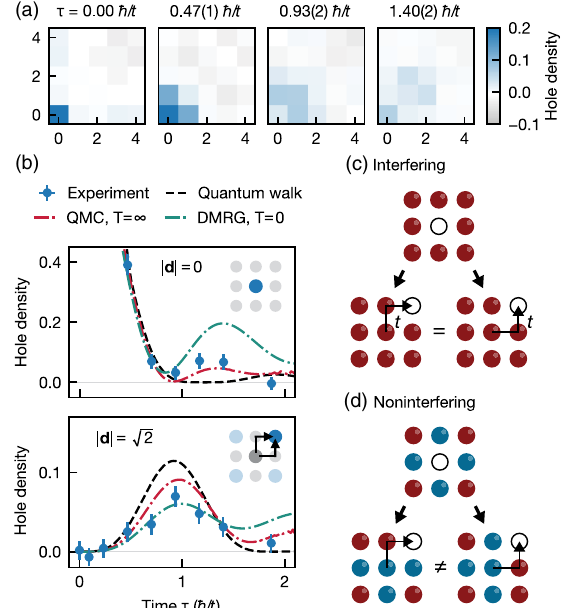
FIG. 2. Effect of quantum interference on short-time density dynamics. (a) Symmetrized average hole densities at short times. The hole initially delocalizes coherently, as indicated by density oscillations on sites surrounding the origin. (b) Short-time evolution of the hole density at the center (distance j d j ¼ 0 ) and on the diagonally adjacent sites ( j d j ¼ experimental data to models featuring a ferromagnetic (non- interacting quantum walk, dashed black line), disordered (non- interacting, spin- 1 = 2 QMC simulation at T ¼ ∞ , dash-dotted red line), or antiferromagnetic spin background (ground-state DMRG simulation at t=J ¼ 2 , dash-dotted green line). The diagonal density shows a decreased oscillation amplitude compared to the quantum walk and QMC simulations. This can be interpreted as a manifestation of quantum interference between two nonequiva- lent hole paths, maximal for a polarized spin background (c) and reduced for an antiferromagnet (d). Here and in the following, error bars indicate a one-sigma statistical uncertainty in the plotted